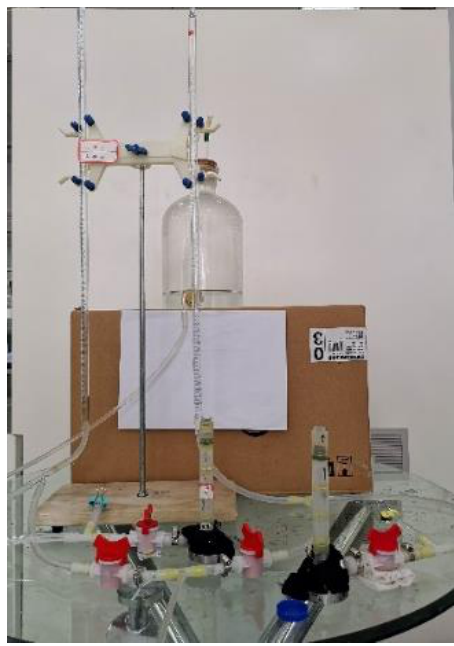
Figure 2. Small osmotic deformation instrument.